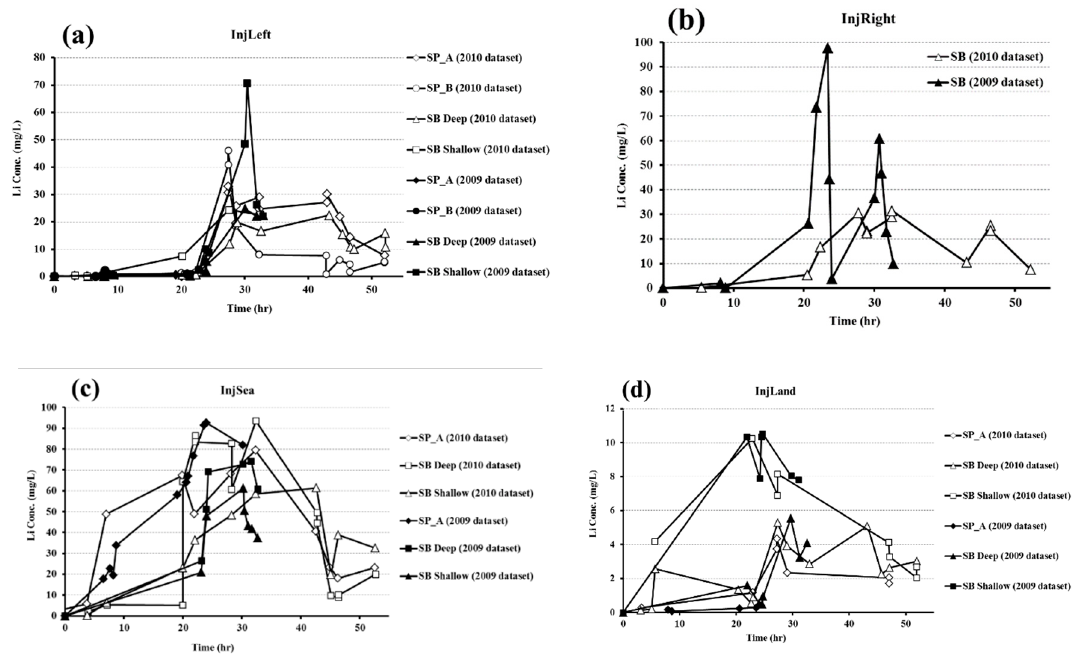
Figure 9. Comparison between the concentration values from the sampling wells, InjLeft ( a ), InjRight ( b ), InjSea ( c ), and InjLand ( d ), for the 2010 dataset and a dataset obtained in a prior year using similar experimental and injection procedures